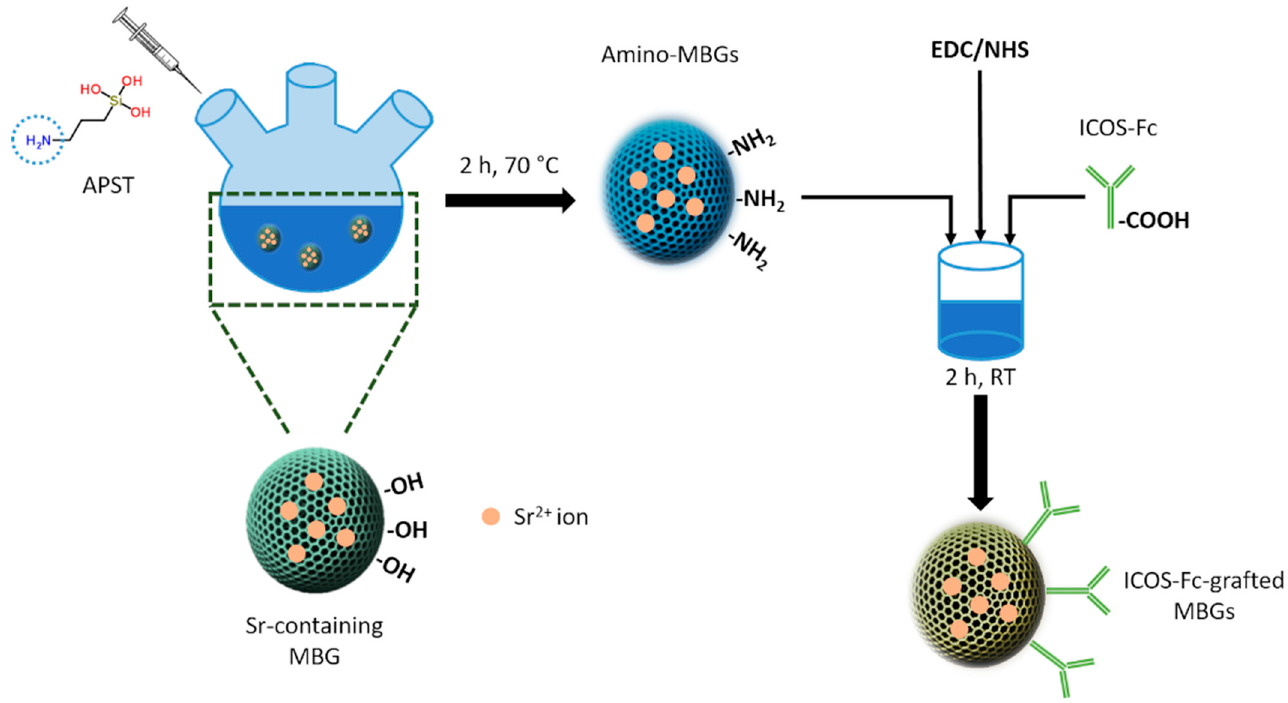
Figure 2. ICOS-Fc grafting on amino-MBGs surface.